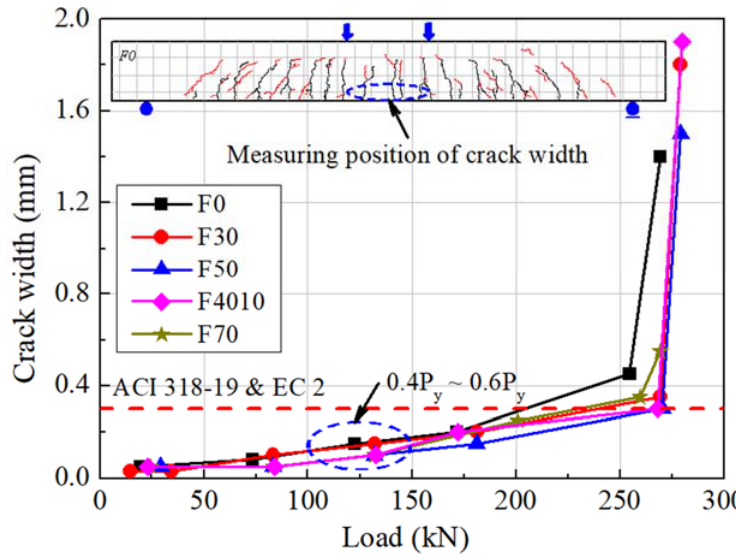
Figure 8. Crack width ‐ load relationships of F